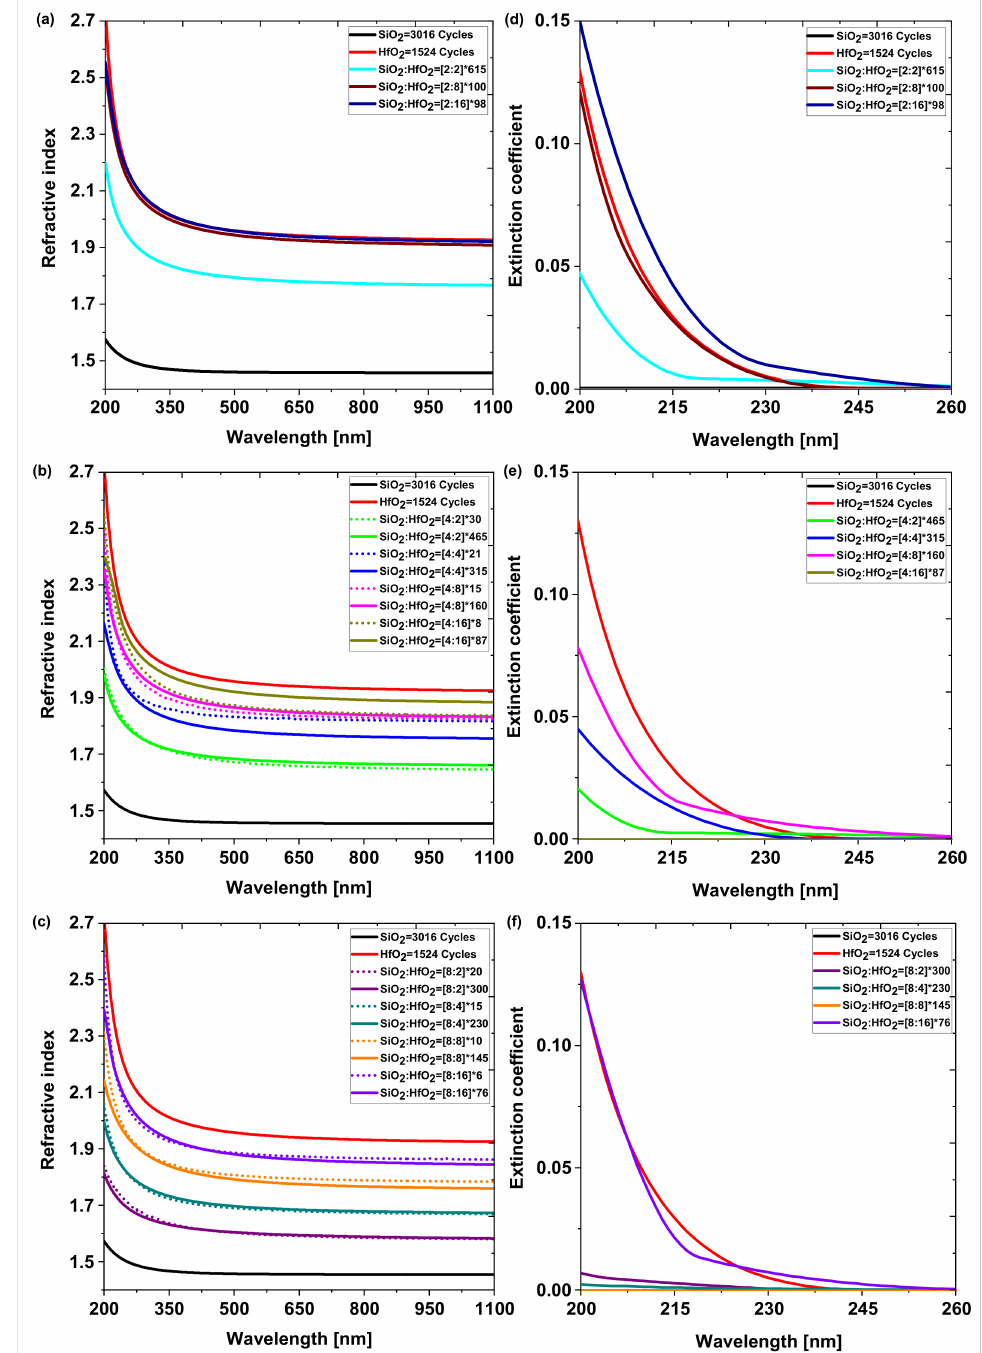
Figure 2. Optical constants for the heterostructures with ( a , b ) 2, ( c , d ) 4, and ( e , f ) 8 cycles of SiO 2